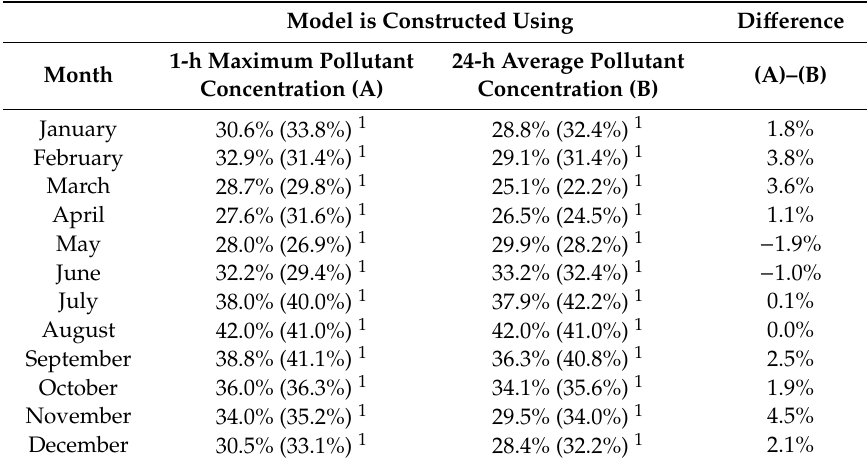
Table 2. Ten-fold cross validation errors from using a decision tree model to predict higher or lower probability of death from respiratory